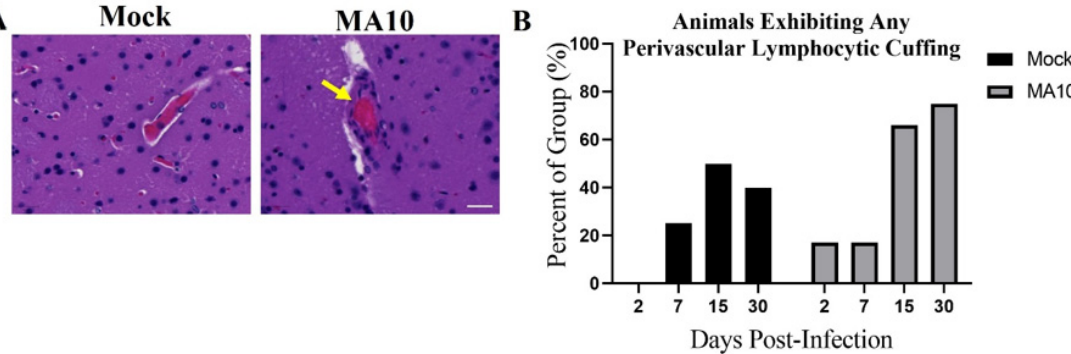
Figure 5. SARS ‐ CoV ‐ 2 (MA10) infection increases perivascular lymphocyte cuffing in the brains